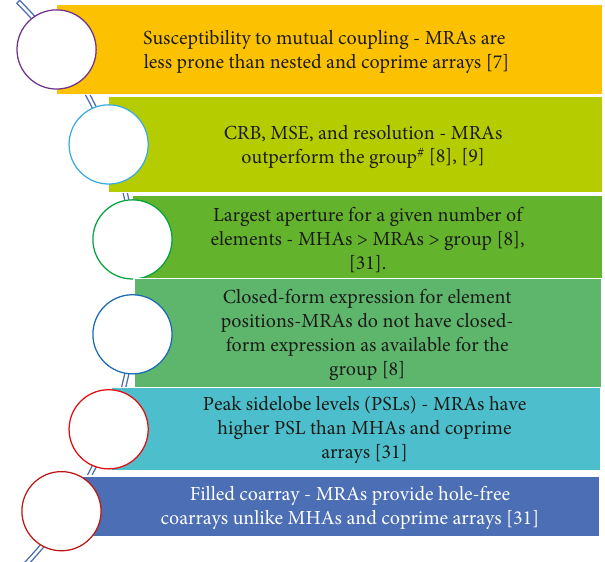
Figure 17: Properties of MRAs and other sparse arrays. #The word “ group ” is used for conciseness in this fi gure and collectively refers to coprime, nested, and super-nested